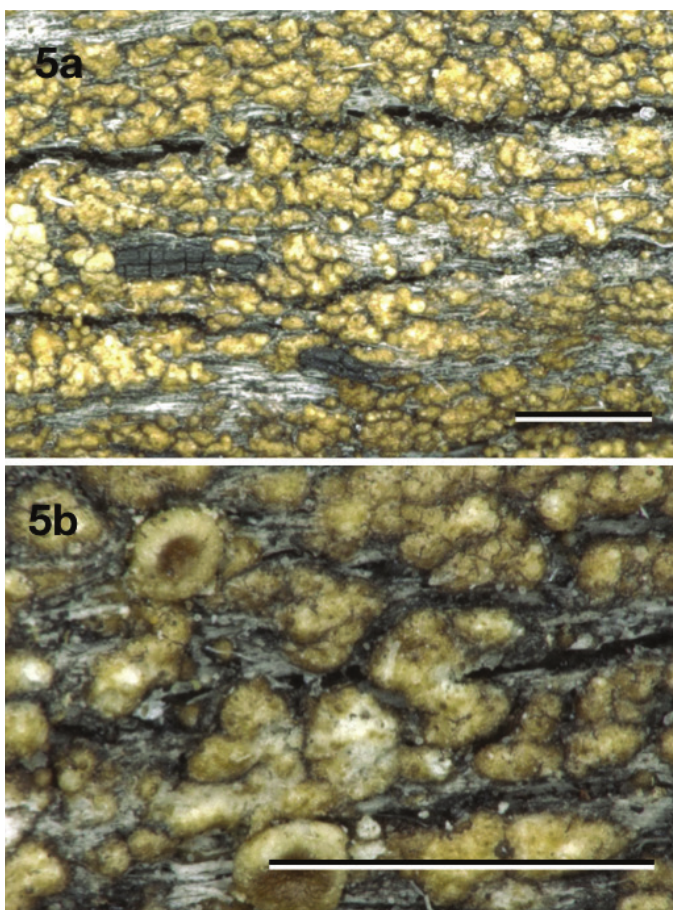
Figure 5. Neoprotoparmelia australisidiata , holotype Kantvilas 289/07 (HO 545660). Scale bar: 1 mm.